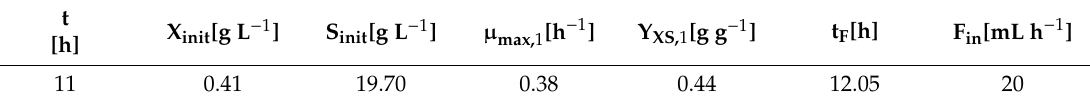
Table A13. Estimated initial concentrations for biomass X init and glucose S init and estimated model parameters for maximum specific growth rate biomass µ max and yield coe ffi cient biomass / substrate Y XS at process timepoint t. Calculated glucose drop time at t F and calculated optimized feed rate F in for timepoint t F .